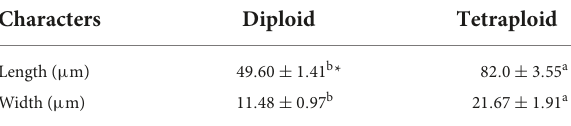
TABLE 7 Chlorophyll fluorescence of diploid and tetraploid Anoectochilus roxburghii. Chlorophyll fluorescence Diploid Tetraploid